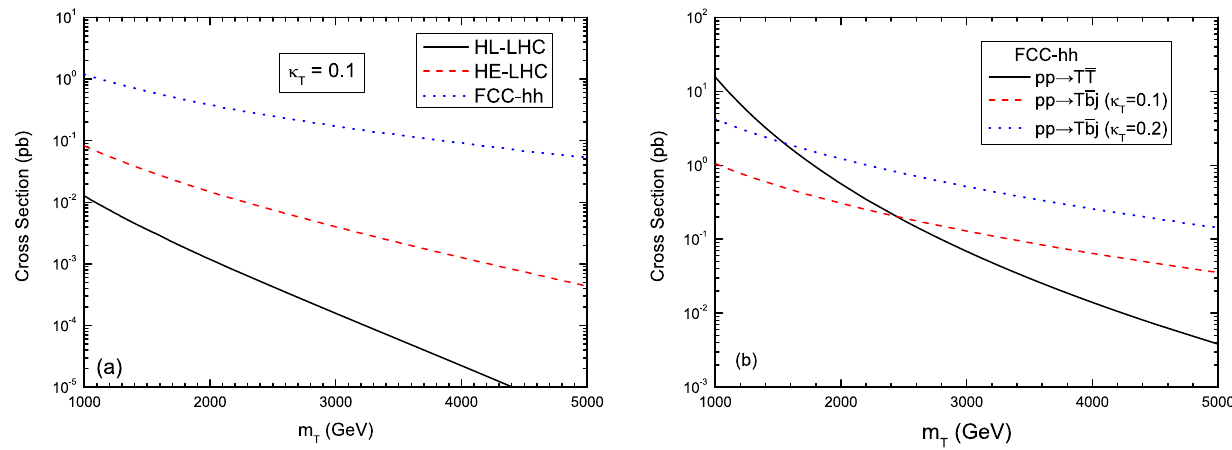
Fig. 2 a The dependence of the cross sections for the process pp → T ¯ b j + ¯ Tbj on the T quark mass m T at 14 TeV LHC, HE-LHC and FCC-hh with κ T = 0 . 1; b the cross sections of top partners single production and pair production versus its mass at the